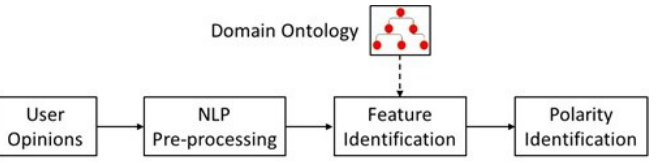
Figure 3. General algorithmic framework for ontology-based sentiment